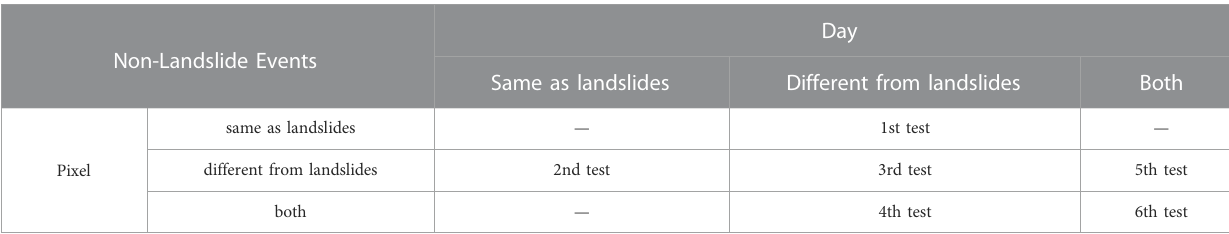
TABLE 1 Summary table of the six tests used in the proposed methodology. Each non-landslide event was selected by comparison with the days and the pixels of the landslide events.